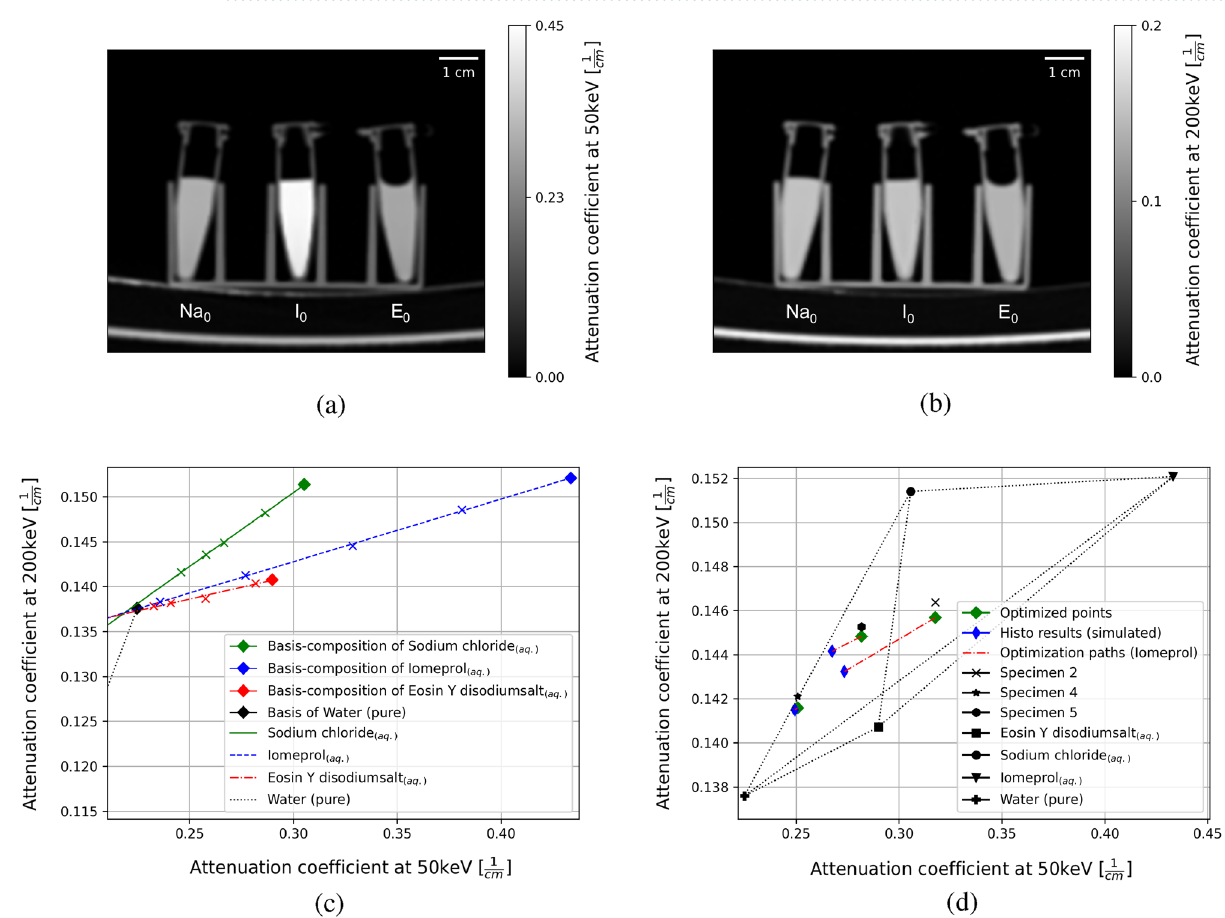
Figure 2. ( a ) Virtual monoE images at 50 keV and ( b ) 200 keV of the three basis compositions sodium chloride (Na 0 ), iomeprol (I 0 ) and eosin Y disodiumsalt (E 0 ). ( c ) The linear relationship of each basis material is shown for different concentrations mixed together in aqueous solution. Linear regressions were then created for the linear dependencies, allowing the endpoints of each basis material to be better determined computationally and with greater statistical accuracy. ( d ) The way of iodine optimization along a characteristic optimization path (red vector) is shown for specimen 2, 4 and 5. The exact results found by the algorithm are shown in Table